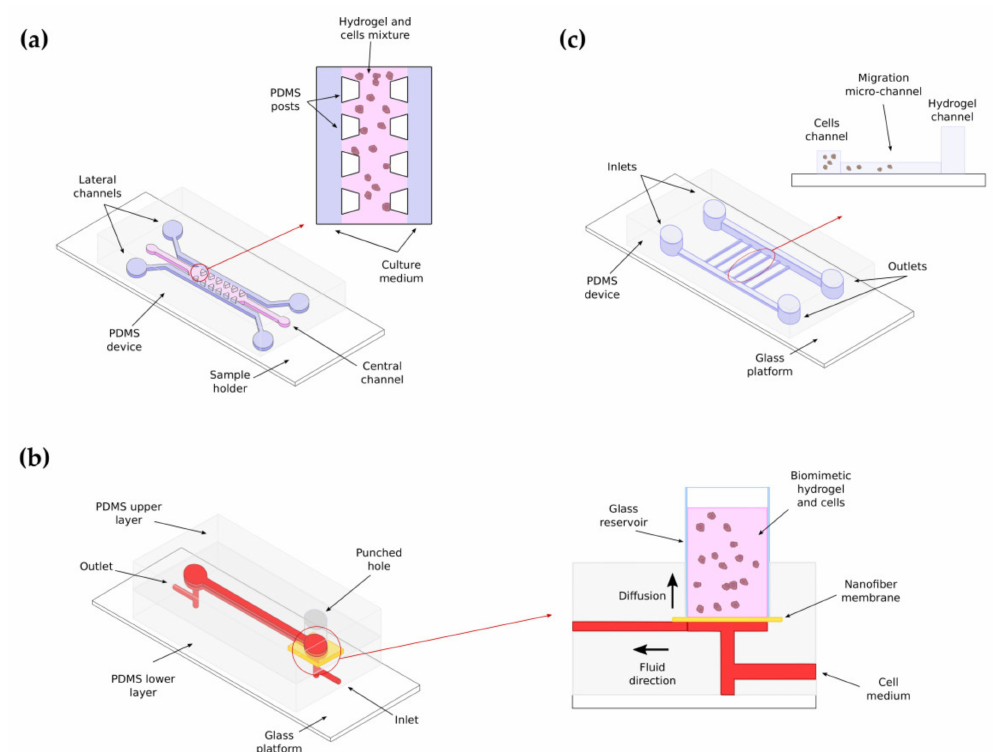
Figure 6. Hydrogel based microfluidic devices for cell migration assays. ( a ) Microfluidic device for studying H1299 lung cancer cell migration capability in collagen and collagen-Matrigel based hydrogel (Adapted from [42]); ( b ) microfluidic device for studying glioma cell alignment and migration capability in hyaluronic acid-based hydrogel (Adapted from [305]); ( c ) Microfluidic device for studying migration effects in neutrophil chemotaxis with a collagen matrix (Adapted from